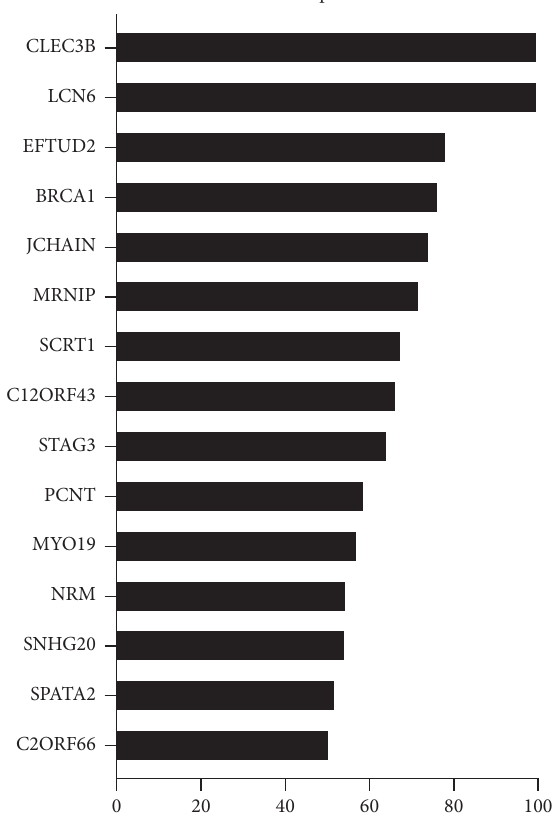
Figure 1: Artificial Neural Network (ANN) analysis of the 75 most significant genes predicting DFS was performed. Shown are the 15 genes along with their adjusted normalized